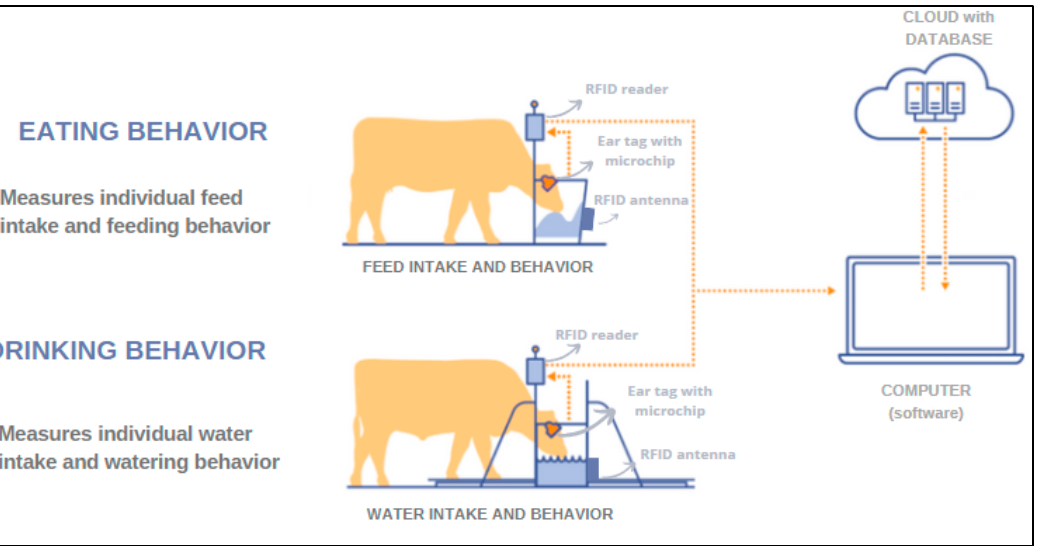
Figure 4. The system individually identifies the animals each time they go to the feeder or drinker and monitors the time they spent there using the radiofrequency identification system (RFID) ear tag. In addition, the system accurately measures the amount of feed/water consumed by that animal through sensors. Data are then transmitted to software. Adapted from [78] but originally created by the authors.